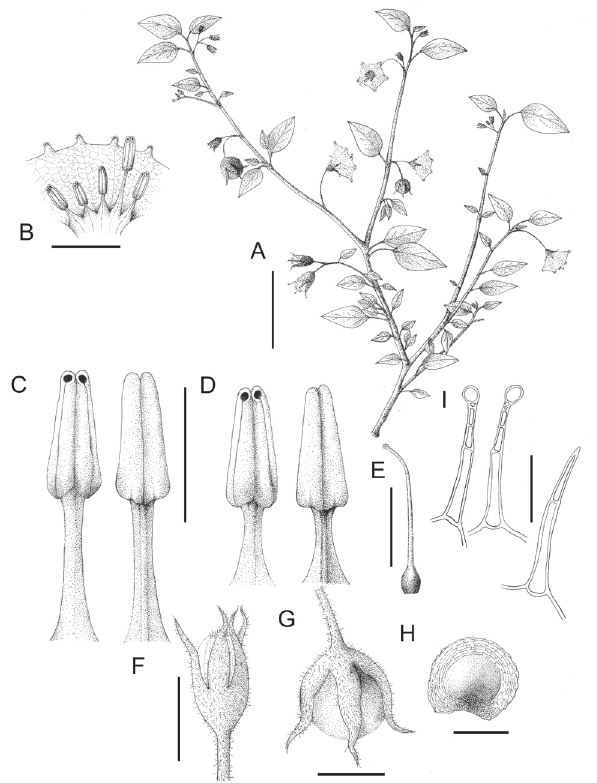
Figure 1. Solanum evolvuloides Giacomin & Stehmann. A Habit B Corolla cross section showing sta- mens C Larger stamen in ventral and dorsal view D Smaller stamens in ventral and dorsal view e Gynoe- cium F Young bud G Fruit h Seed i Detail of the hairs of stems, peduncles and calyces (glandular) and leaves (eglandular). All from Mattos-Silva s.n. (CEPEC-15698). Scale bars A= 3 cm; B, C, D, E, F and G = 5 mm; H = 2 mm ; I = 0.2